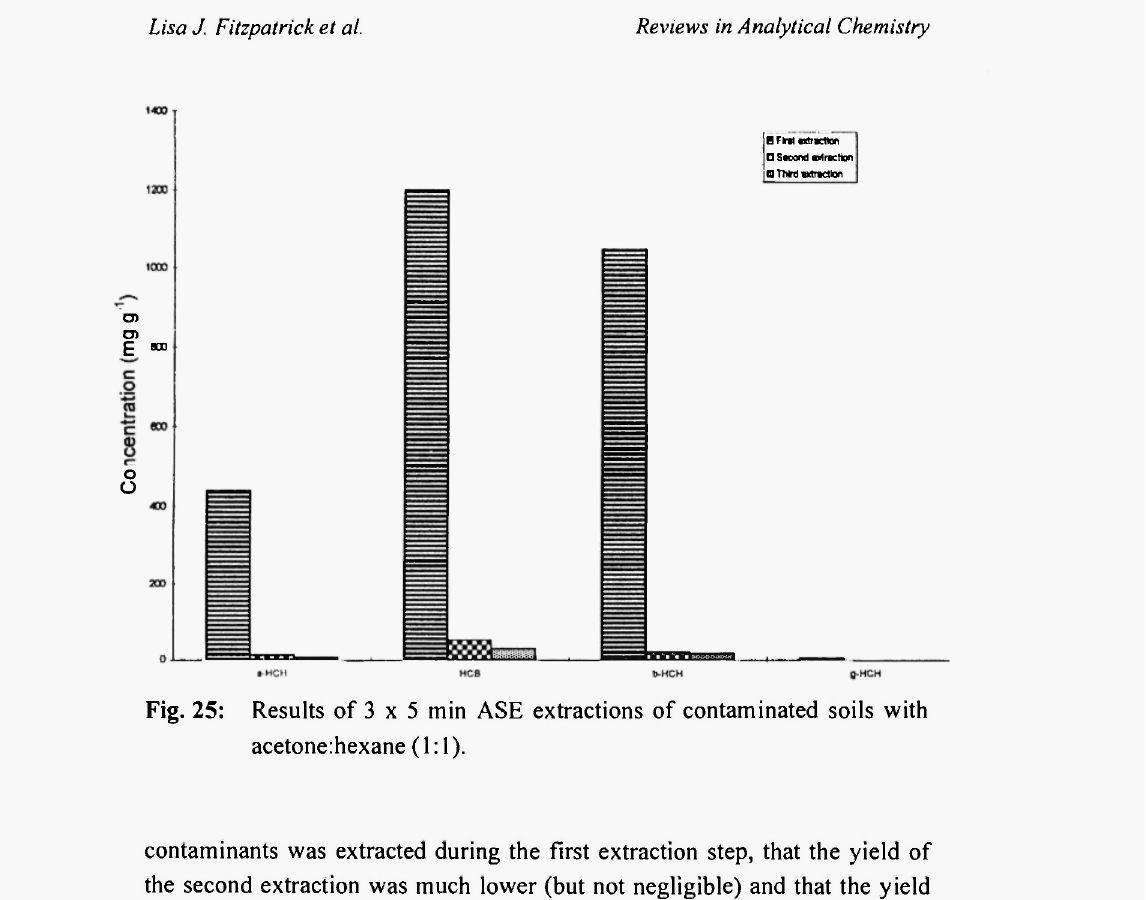
Fig. 25: Results of 3 χ 5 min ASE extractions of contaminated soils with acetone:hexane